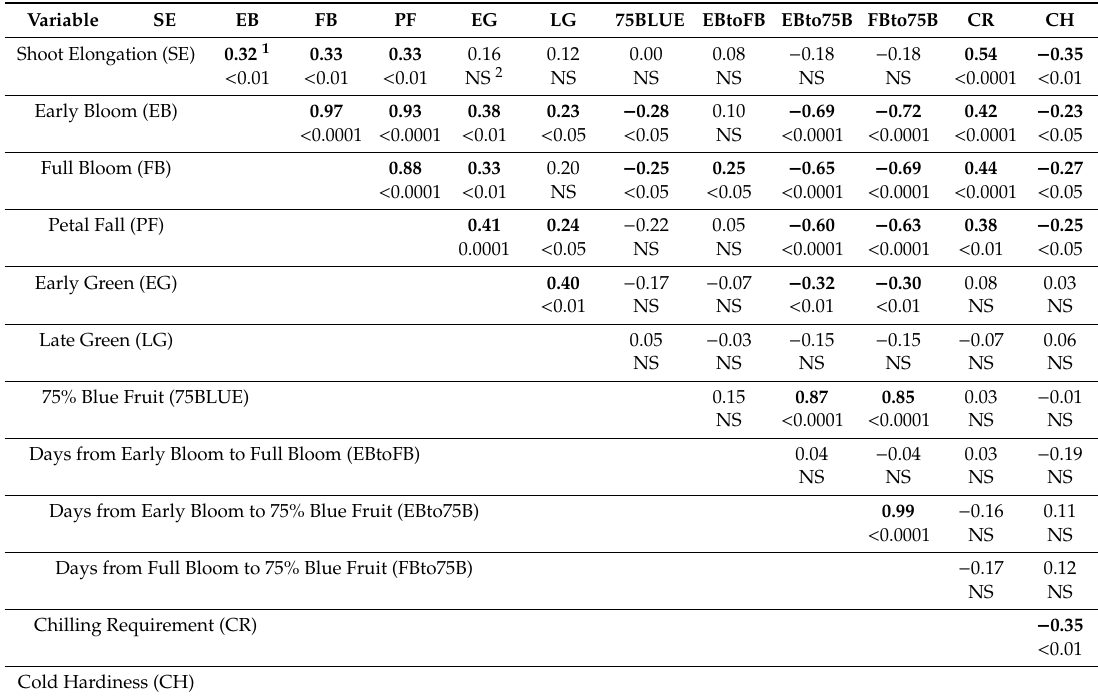
Table 2. Spearman correlation coe ffi cients among the growth stage